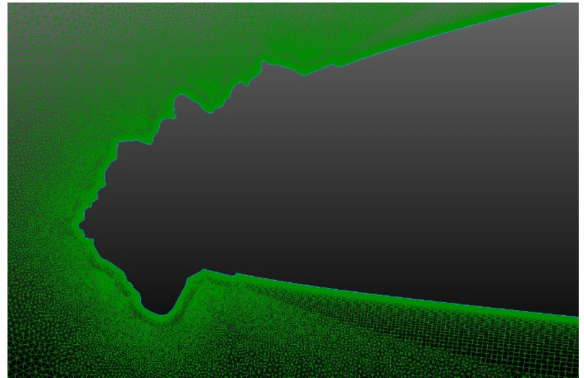
Figure 3. Numerical T-Rex grid for the glaze ice shape, generated in Pointwise with a structured resolution of the boundary-layer and unstructured far field.